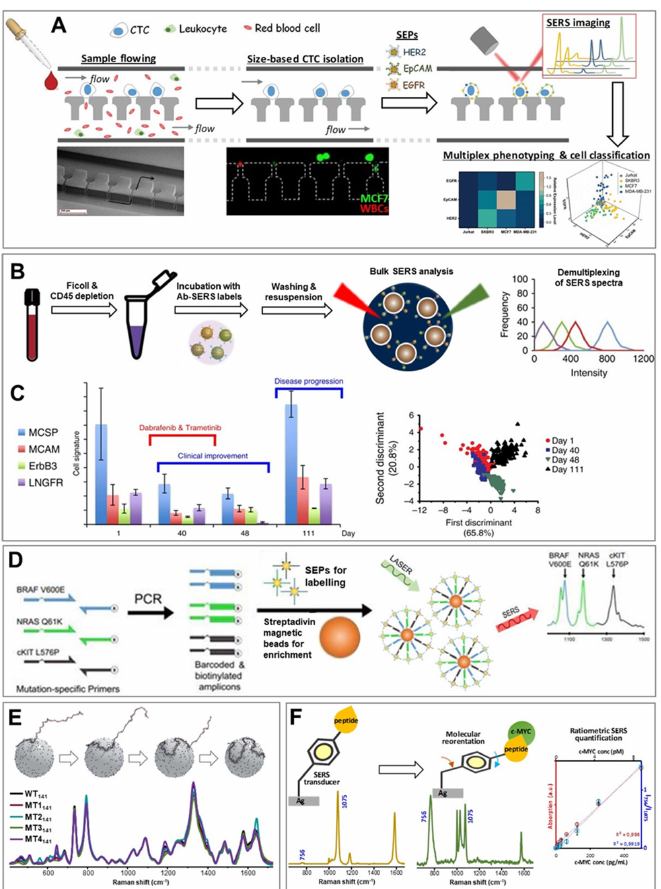
Figure 2. ( A ) Size-based capturing of circulating-tumor cells (CTCs) from blood, and multiplexed SERS phenotyping and chemometric classification of single cancer cells. (i) CTCs are isolated by flowing the whole blood through a nanogap array: see SEM image, arrow indicates the flow direction, and fluorescence image of fluorescently labelled individual cells (green, breast cancer cells MCF7; red, white blood cells) trapped at the edge of the pillar structure (dash lines show the edge of the pillar structure). (ii) Incubation with aptamer-SEPs enables the acquisition of SERS spectra that, upon deconvolution, yield single-cell SERS phenotypic signatures. Adapted with permission from ref. [54]. Copyright 2018, Wiley-VHC. ( B , C ) Real-time evolution of the phenotypic distribution of different cancer cell subpopulations: ( B ) Schematic outline of the experimental workflow. The ensemble of CTCs labelled with antibody-SEPs is interrogated via average analysis. Demultiplexing of the acquired SERS spectra is performed to yield SERS intensities from each code plotted as a frequency distribution curve. ( C ) Phenotypic signatures of CTCs in response to treatment. Patient with stage IV melanoma (day 1) was treated with dabrafenib and trametinib. After 1 month, treatment was discontinued due to toxicity. Cluster analysis of the SERS data is also reported. Adapted from Tsao et al., Nature Communications, 2019, 1482; DOI: 10.1038 / s41467-018-03725-8 [55], licensed under CC BY 4.0. ( D ) PCR-SERS integration for identification of tumor DNAs using SEPs. Biotin-labelled amplicons of tumor DNA are recognized by SEPs and, subsequently, separated from the media with streptavidin-coated magnetic beads prior to multiplex SERS analysis. Adapted from Wee et al., Theranostics, 2016, 6, 1506; DOI: 10.7150 / thno.15871 [56], licensed under CC BY-NC [56]. ( E ) Conformational classification of K-Ras point mutations (MT1-5) in long single-stranded DNAs via direct SERS analysis. Adapted with permission from [57]. Copyright 2017, WILEY-VCH. ( F ) Detection of the oncoprotein c-MYC in biological fluids using peptidic receptor derivatized with a SERS transducer which undergoes structural rearrangement upon target binding. The resulting spectral alterations, expressed as ratiometric intensities of two spectral marker bands at 756 and 1075 cm − 1 , are directly correlated with the c-MYC concent. Adapted with permission from [58]. Copyright 2016, American Chemical